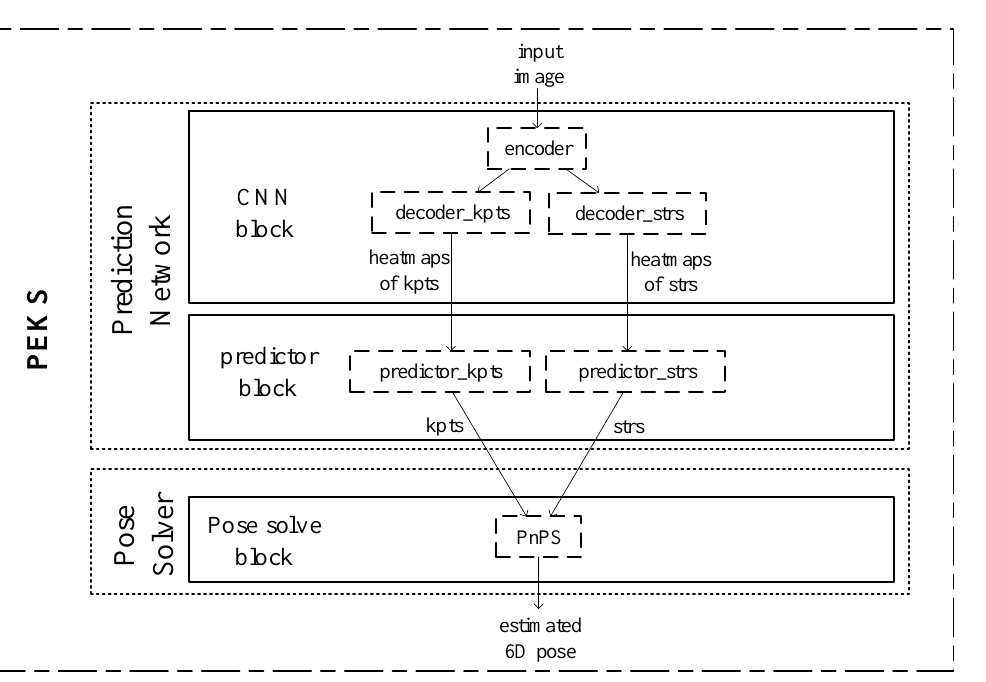
Figure 5. Block diagram of our approach. Given a single RGB image of an aircraft, we utilize a CNN block to generate the heatmaps of the intermediate representation which are keypoints and structures. Then a predictor block is employed to predict the keypoints and structures. The 6D pose parameters are estimated by the pose solve block by the PnPS algorithm. For convenience, we denote keypoints as kpts and structures as strs in this